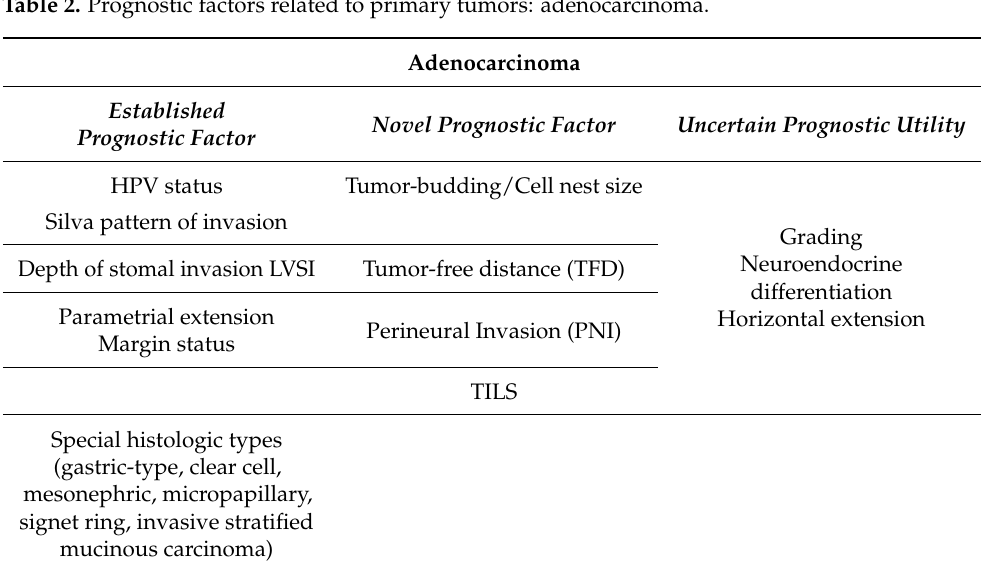
Table 2. Prognostic factors related to primary tumors: